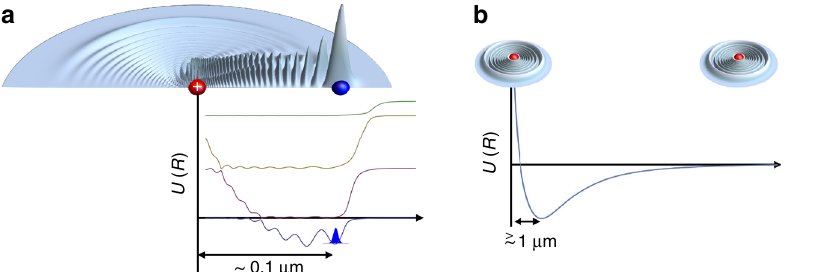
ð k ÞÞ the s -wave 1 tan ð δ k ! 0 s k